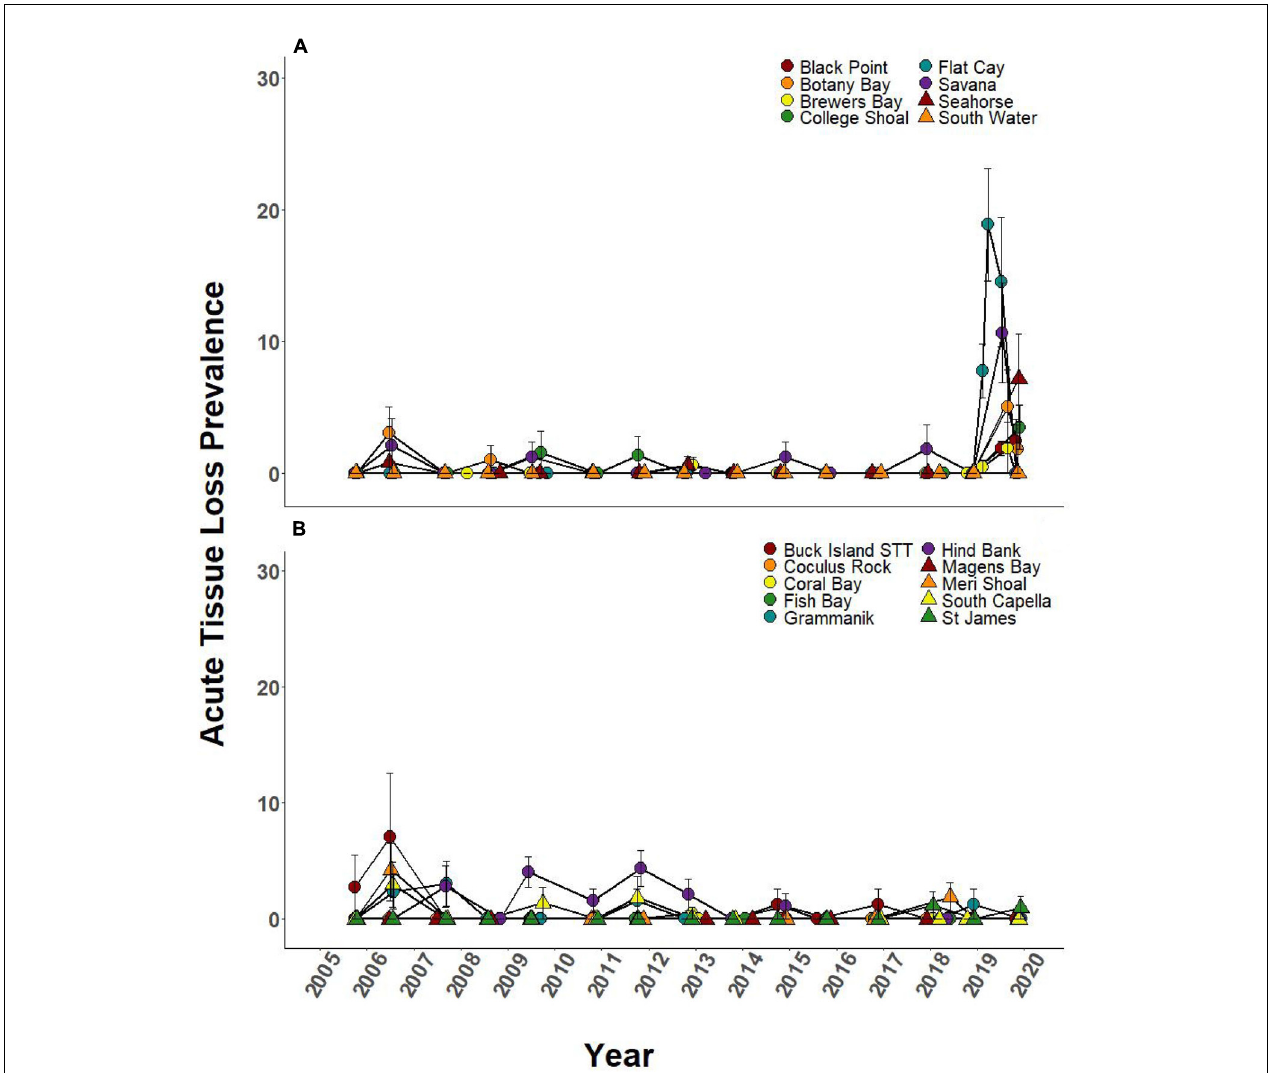
FIGURE 5 | Prevalence of ATL due to disease ( ± SEM) at northern U.S Virgin Islands (USVI) TCRMP locations from 2005 to 2019. Acute tissue loss refers to colonies exhibiting large lesions consistent with disease. Prior to 2019, ATL was primarily due to white plague, while in 2019, ATL was almost exclusively due to SCTLD. (A) Locations with SCTLD present; (B) Locations with no SCTLD present as of December